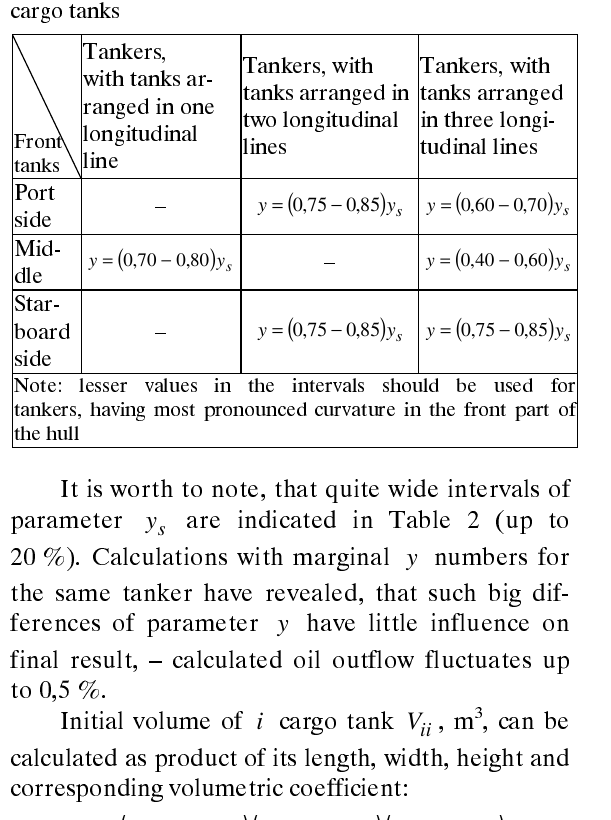
by for front y y s